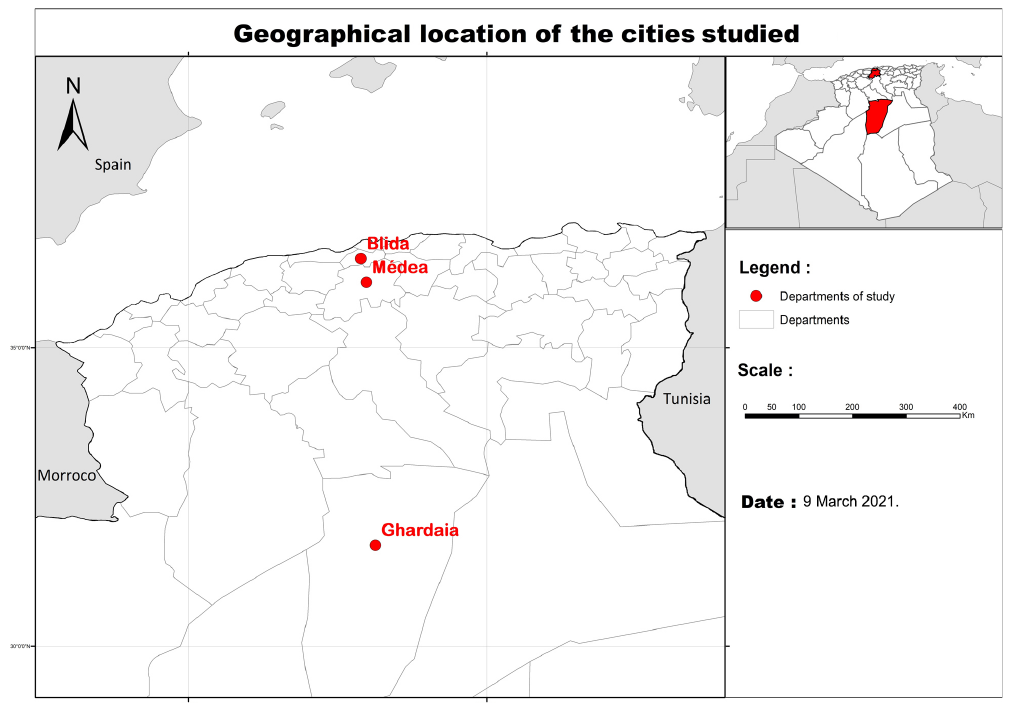
Fig. 1. location of Blida, Medea and Ghardaïa cities. Source: drawn by